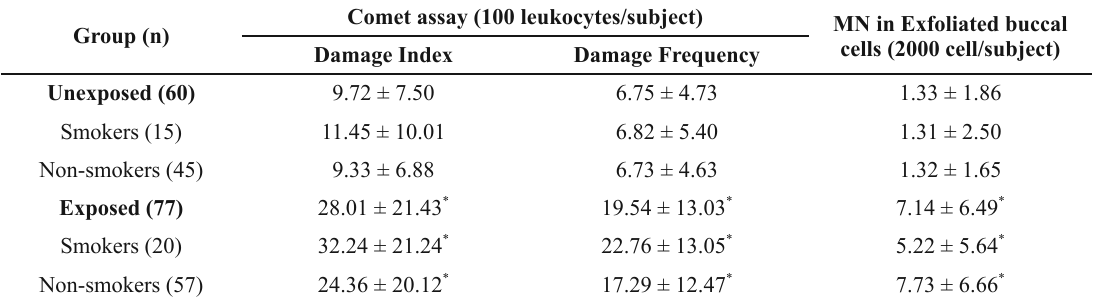
Mean values (mean ± standard deviation) obtained in the cytogenetic analysis in unexposed and exposed groups. Group (n)